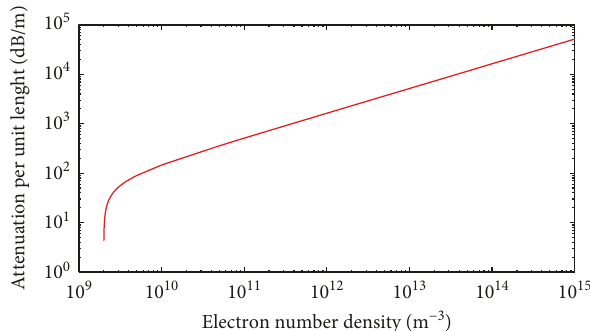
Figure 2: Attenuation per unit length versus electron number density for